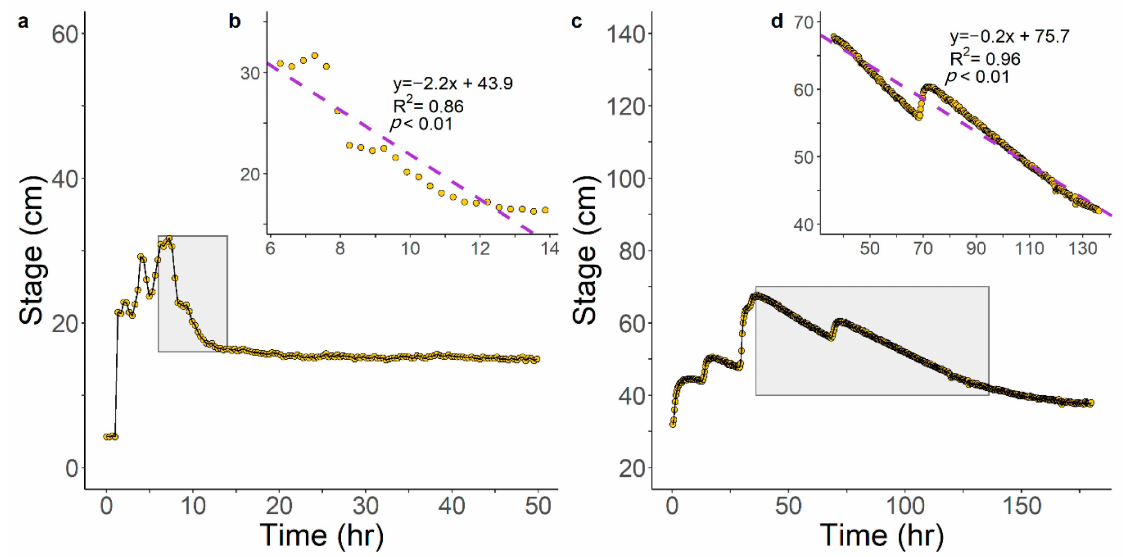
Figure 10. Outlet stage response to a 0.6 cm rain event in December of 2018 for the dry detention basin ( a , b ). Outlet stage response to a 0.6 cm rain event for the wetland in December of 2019 ( c , d ). The slope of the stage decline for the basin ( b ) was 1 order of magnitude steeper than the wetland ( d ). Grey-shaded boxes denote range of inset graphs ( b , d ).